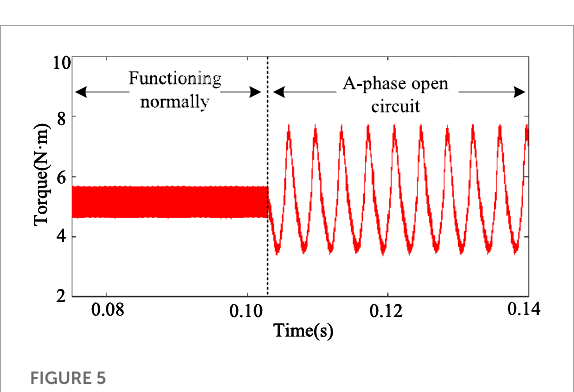
FIGURE 4 Motor current under normal and open-circuit fault conditions.